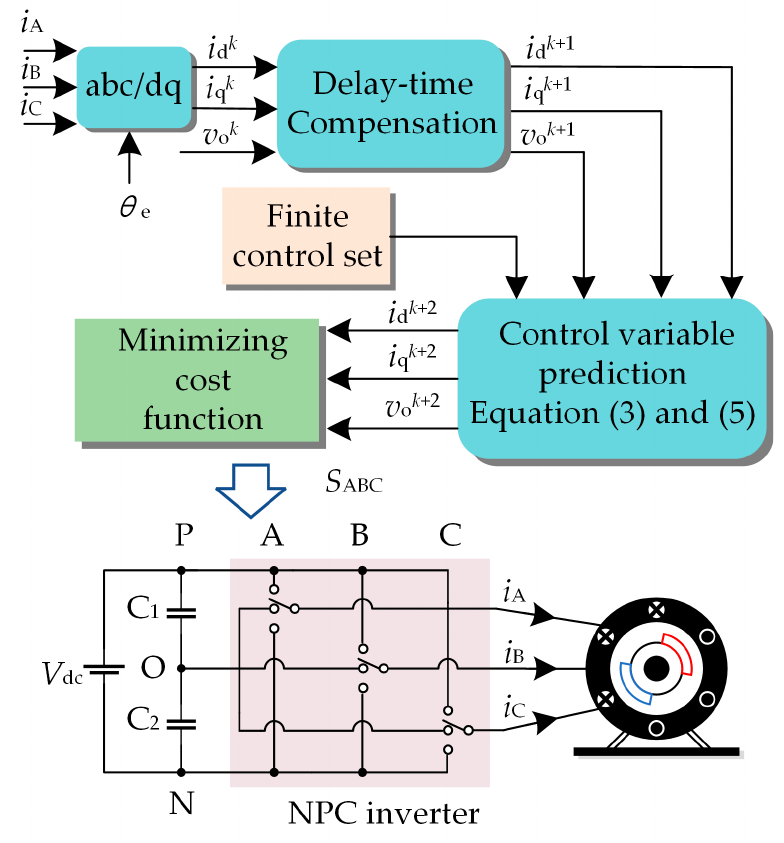
Figure 3. Structure block diagram of traditional MPCC.